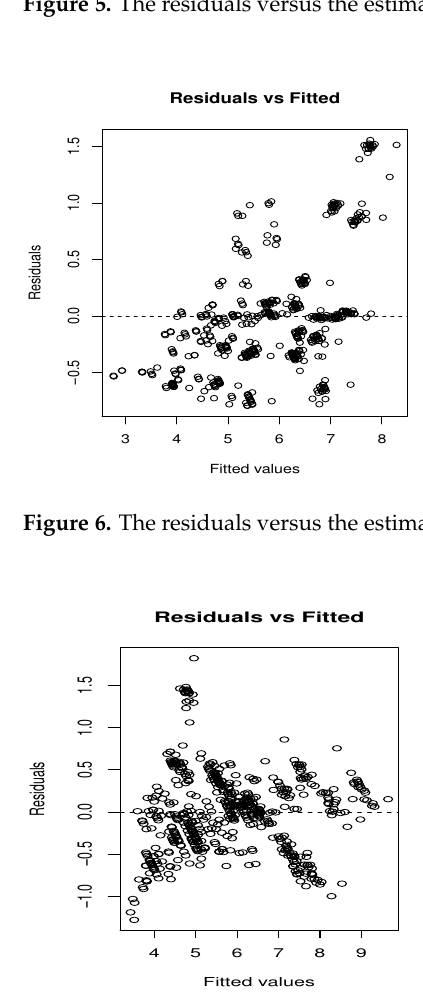
Figure 5. The residuals versus the estimated responses of the GP model.